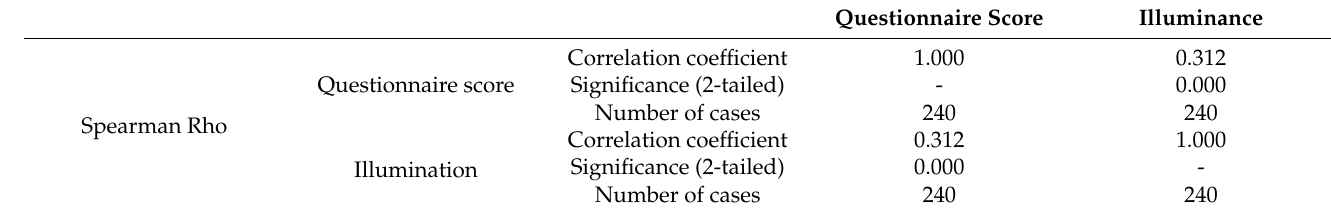
Table 8. Spearman correlation coefficient of illumination and visual comfort